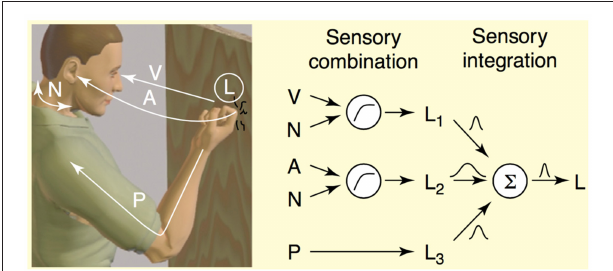
FIGURE 1 | Illustration of cue combination and integration of the perception during knocking on wood from Ernst and Bülthoff (2004). Sensory cue combination occurs between sensory signals that are not redundant, which can be represented in different units or coordinate systems, and which might reflect complementary aspects of the environment, for example visual or auditory information (Ernst and Bülthoff, 2004). This figure from Ernst and Bülthoff (2004) depicts how three sensory estimates about the location (L) of the knocking event are combined to form a stable percept. Information from visual (V), auditory (A), and proprioceptive (P) sensory percepts comprise three different signals about location. Before these signals can be integrated, V and A signals can be combined with the proprioceptive signals (N) to be transformed into body-centric coordinates with the same units. Following that, the three signals (L 1 , L 2 , L 3 ) are integrated with their reliabilities to form a coherent percept of the location of the knocking event. Sensory cue integration occurs between so-called redundant signals, or signals that are in the same units or coordinates and that reflect the status of the same aspect of the stimulus in the